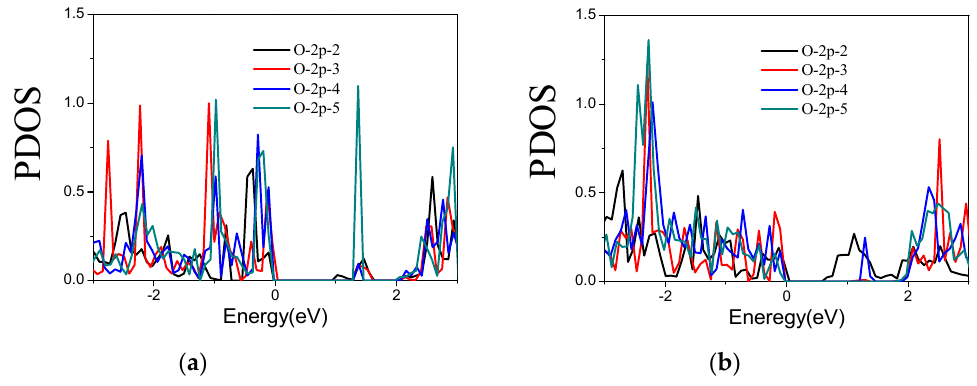
Figure 6. PDOS of 1-O-doped WS 2 monolayers with ( a ) V S and ( b ) V 2S types of vacancy defects. The value of O-2p-X (X = 2, 3, 4 and 5) represents the size of WS2 monolayer supercell (X × X × 1).